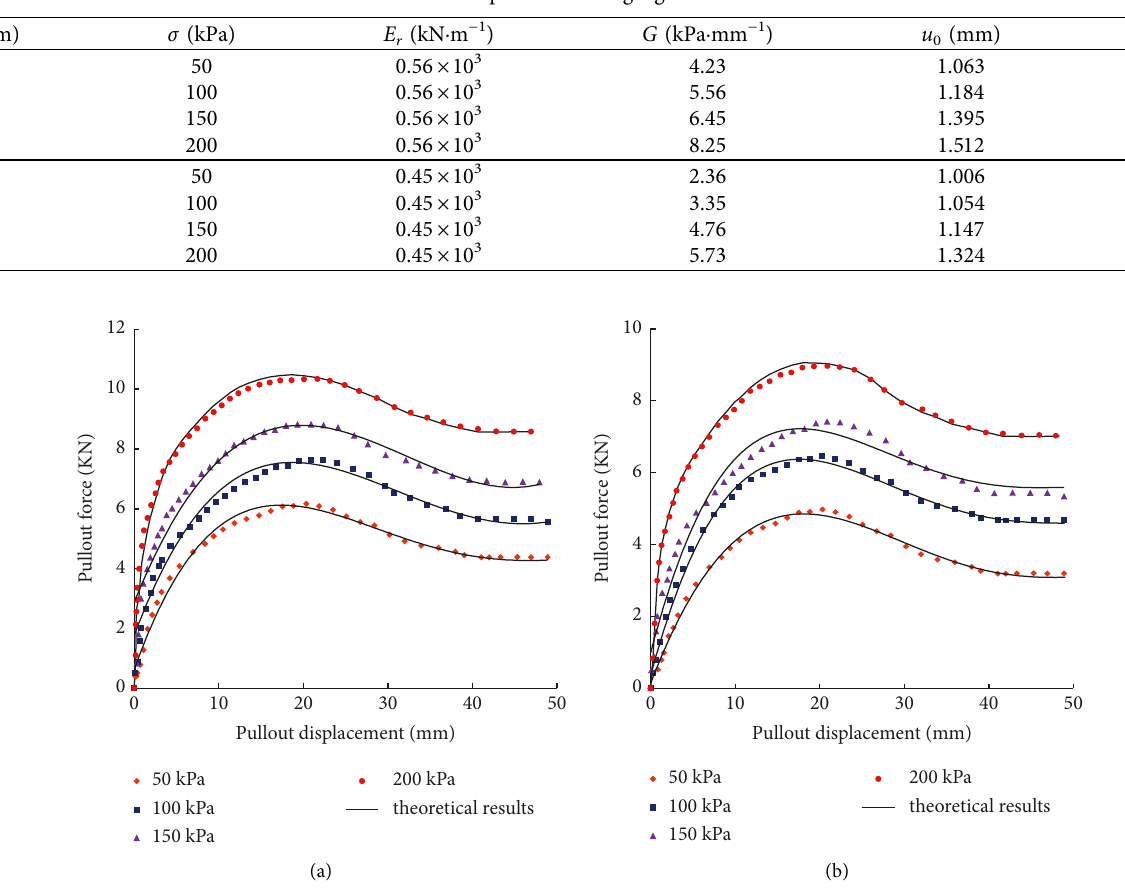
Figure 10: Comparison of test results and theoretical results. (a) s � 35cm. (b) s �